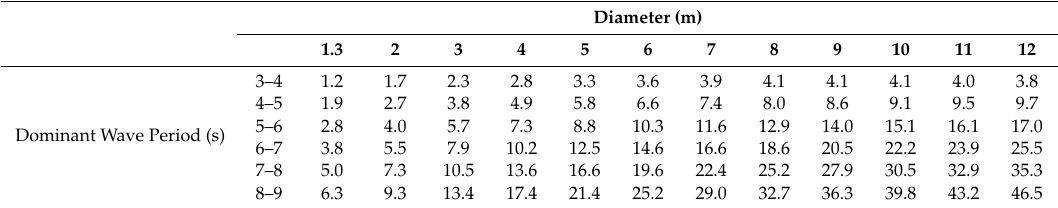
Table 3. Draft for di ff erent diameters and wave period to achieve resonance (density of material = density of steel).